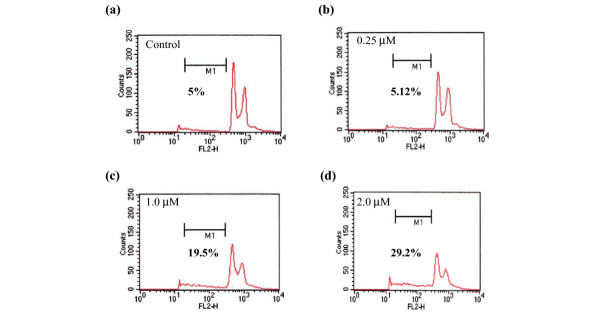
Apoptosis induced by bis-aziridinylnapthoquinone (AZ-1). BC-M1 cells were treated in 24-hour culture with (a) dimethylsulfoxide control, (b) 0.2 μM AZ-1, (c) 1.0 μM AZ-1, or (d) 2.0 μM AZ-1 before propidium iodide staining and analysis of the DNA content. Apoptosis is apparent from the large population of cells with increased DNA content in the sub-G1 area (M1 area). FL2-H, fluorescence two-peak high.